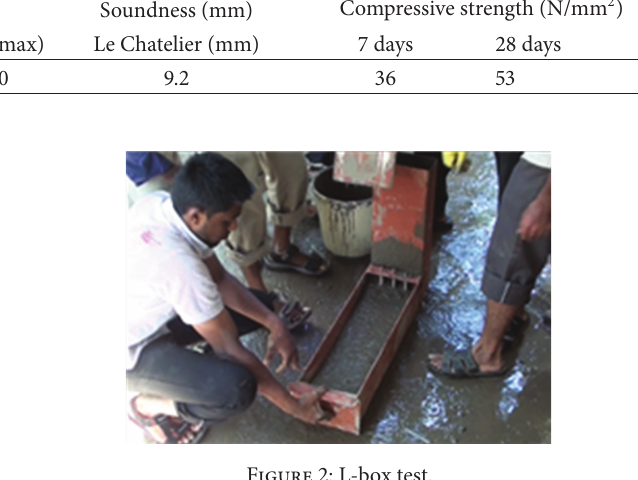
Figure 2: L-box test.